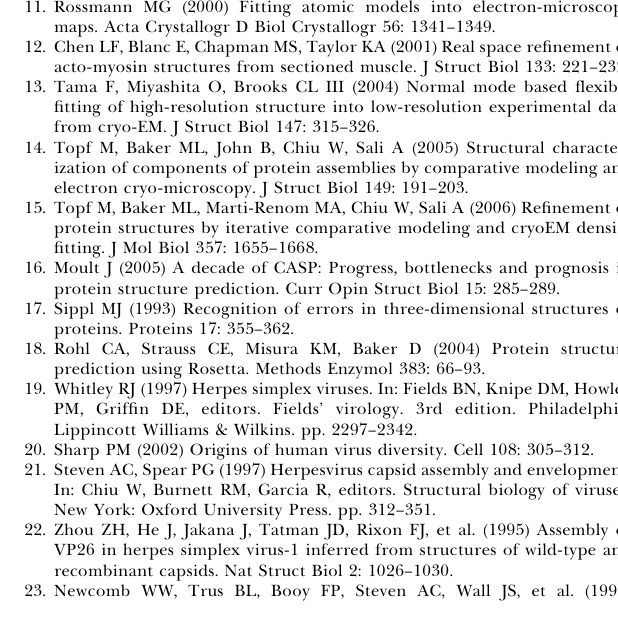
Figure S4. Capsid Protein